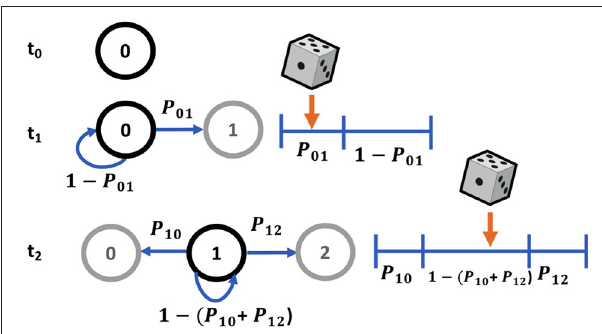
FIGURE 4 | Markov sampling scheme for state transitions using partitions of unity.